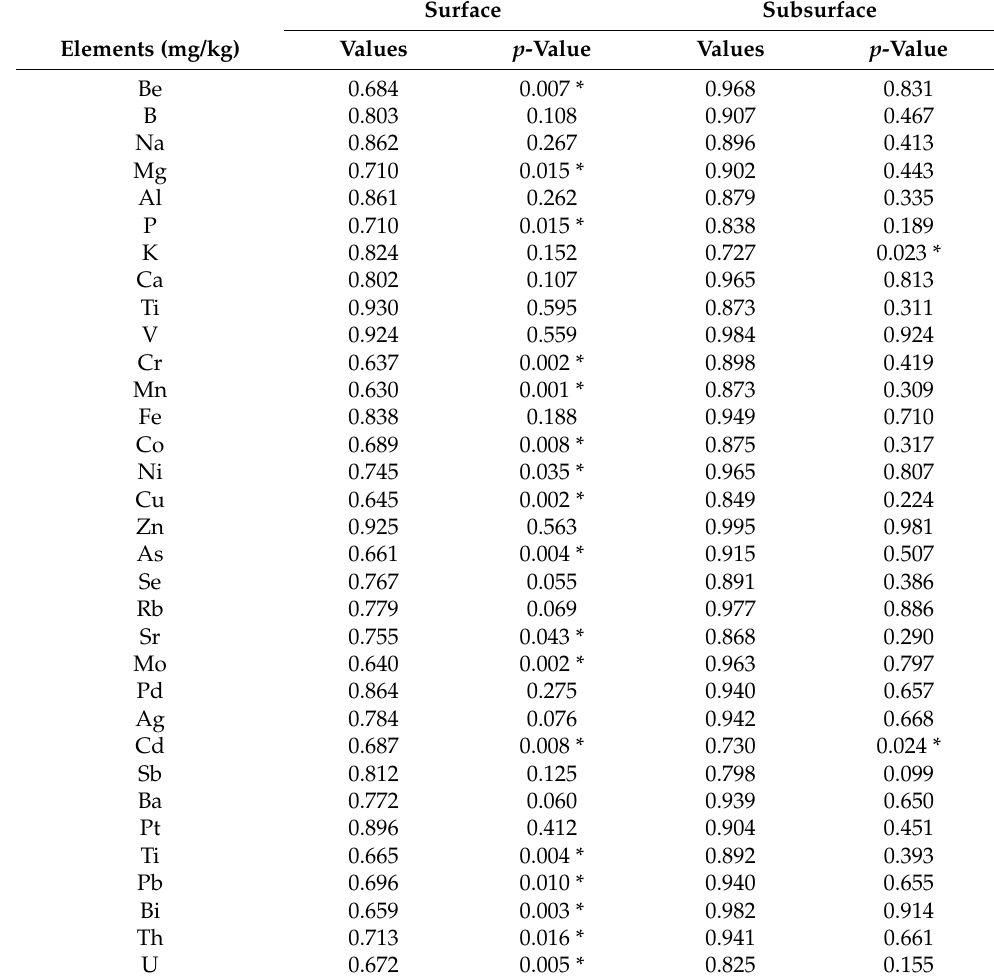
Table 6. Results of the Shapiro–Wilk test for normality distribution.